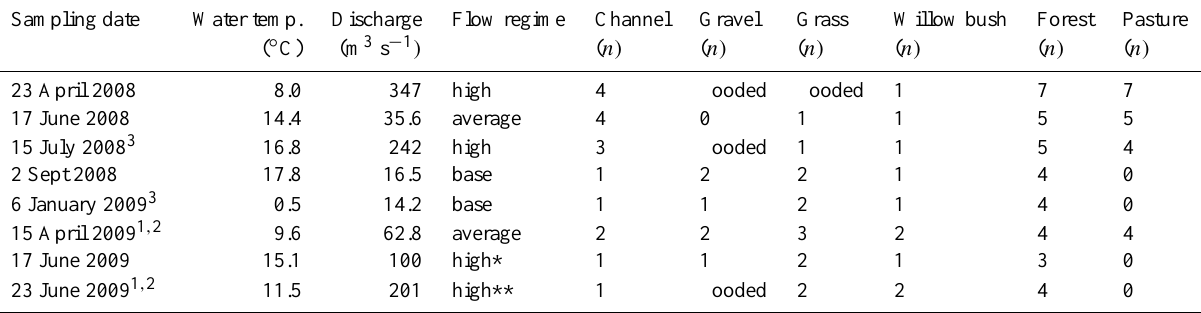
Table 1. Temperature, mean discharge, flow regime of the river Thur, and the number ( n) of samples taken or piezometers sampled in each riparian zone during the sampling campaigns.